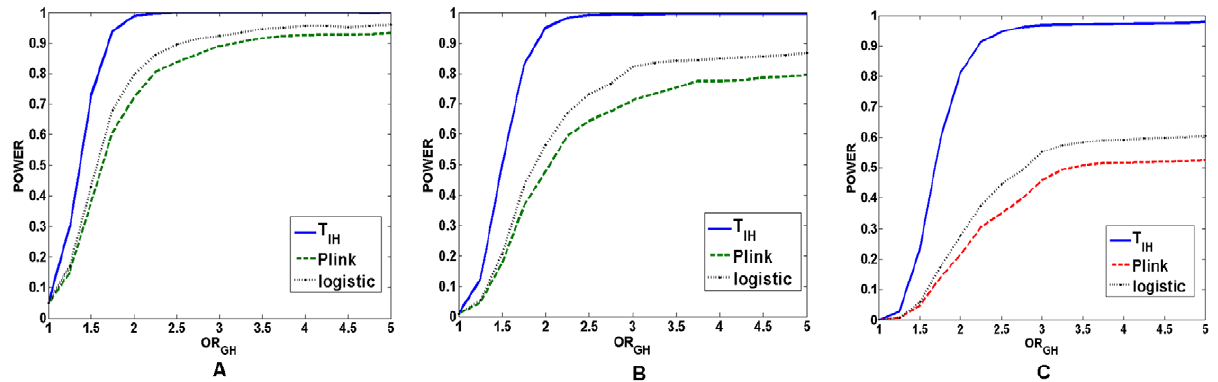
Figure 4. Power of the statistics for testing interaction between two linked loci under additive disease model. (A) The power of the test statistic T IH , the ‘‘fast-epistasis’’ in PLINK and logistic regression for testing interaction between two linked loci analysis as a function of traditional odds-ratio OR GH under a two-locus additive | additive disease model, where the number of individuals in both the case and control groups is 1,000, the significance level is 0.05, and the odds-ratios at two loci were OR G ~ OR H ~ 1 . (B) The power of the test statistic T IH , the ‘‘fast-epistasis’’ in PLINK and logistic regression for testing interaction between two linked loci analysis as a function of traditional odds-ratio OR GH under a two-locus additive | additive disease model, where the number of individuals in both the case and control groups is 1,000, the significance level is 0.01, and the odds-ratios at two loci were OR G ~ OR H ~ 1 . (C) The power of the test statistic T IH , the ‘‘fast-epistasis’’ in PLINK and logistic regression for testing interaction between two linked loci analysis as a function of traditional odds-ratio OR GH under a two-locus additive | additive disease model, where the number of individuals in both the case and control groups is 1,000, the significance level is 0.001, and the odds-ratios at two loci were OR G ~ OR H ~ 1 .